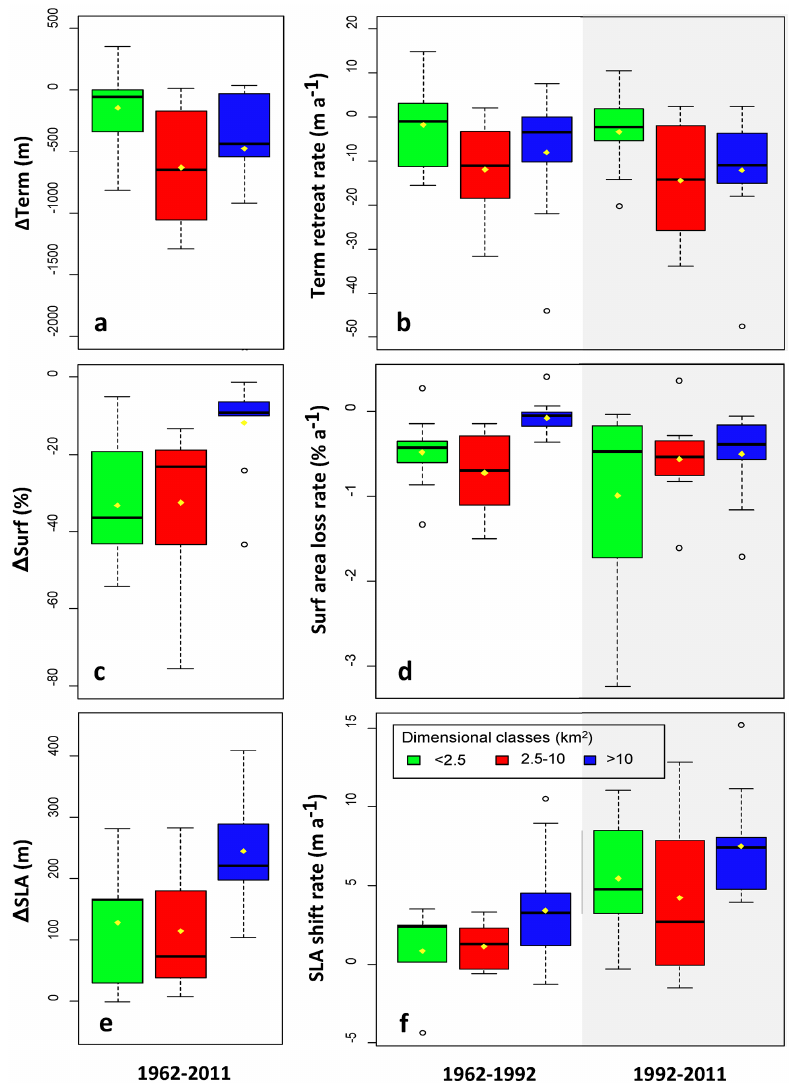
Figure 7. Differences among three-dimensional classes of glaciers ( < 2.5km 2 ; 2.5–10km 2 ; > 10km 2 ) in terms of cumulative changes in the overall 1962–2011 period: (a) terminus retreat (m); (c) surface area loss (%); (e) shift of SLA (m). Differences in terms of annual rate of change between 1962–1992 and 1992–2011 periods; (b) annual terminus retreat rate (ma − 1 ); (d) annual surface area loss rate (%a − 1 ); (f) shift rate of SLA (ma − 1 ). All percentages refer to the initial year of the analysis